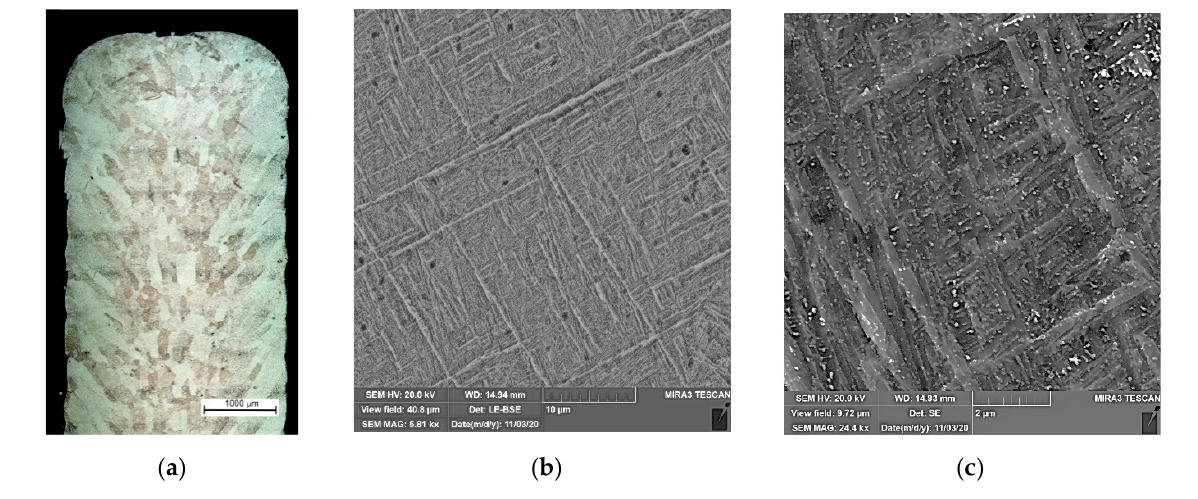
Figure 2. ( a ) Cross-section of the buildup wall; ( b , c ) microstructure of the DLD-processed Ti-6Al- 4V